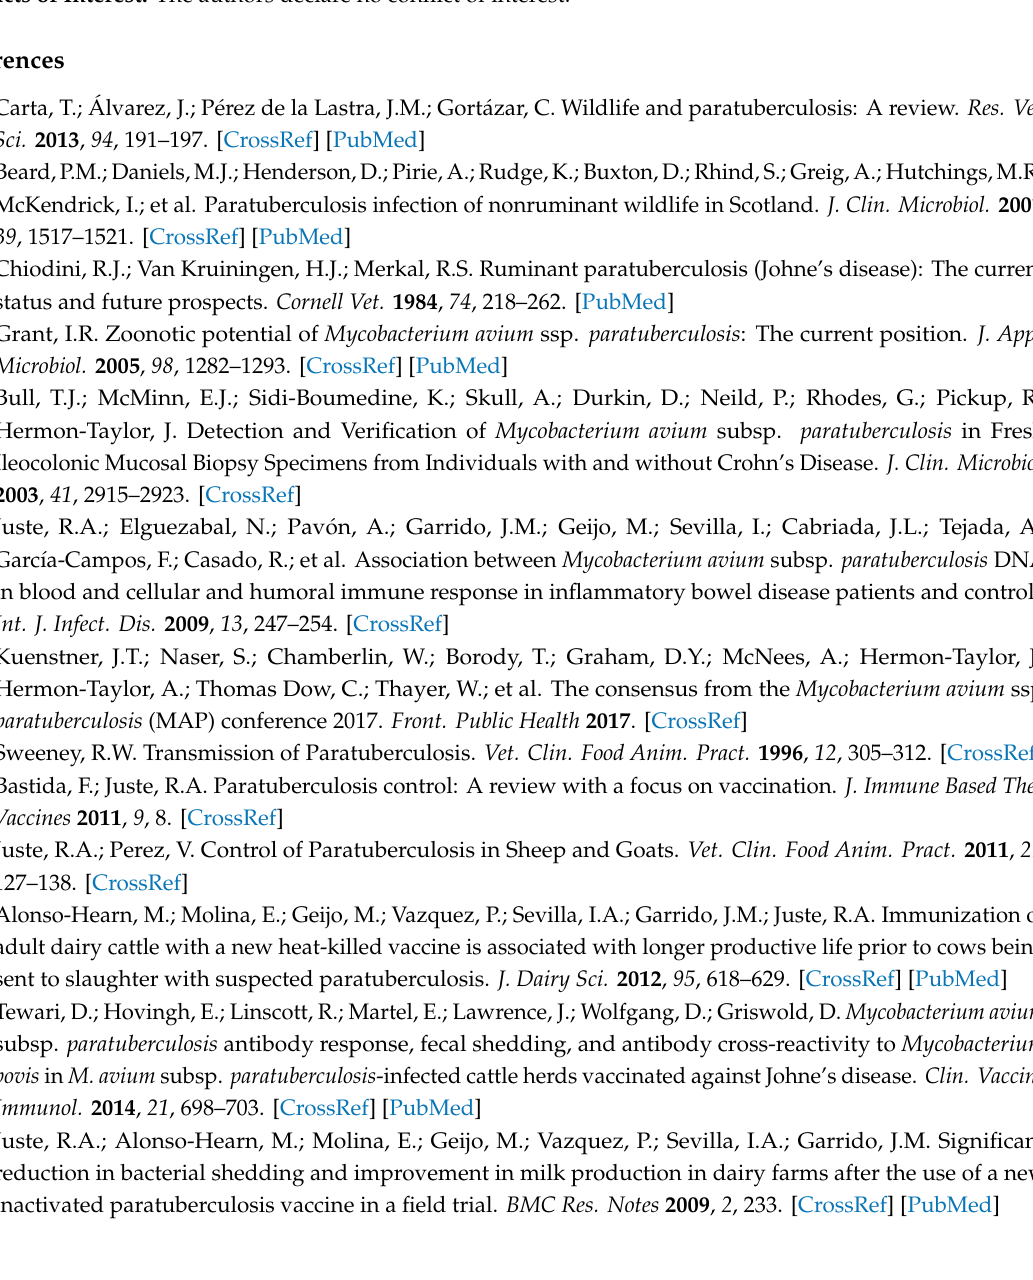
S1: Gross pathology observed in the digestive system. Figure S2: Vaccination inoculation sites, Figure S3: Macrophage polarization